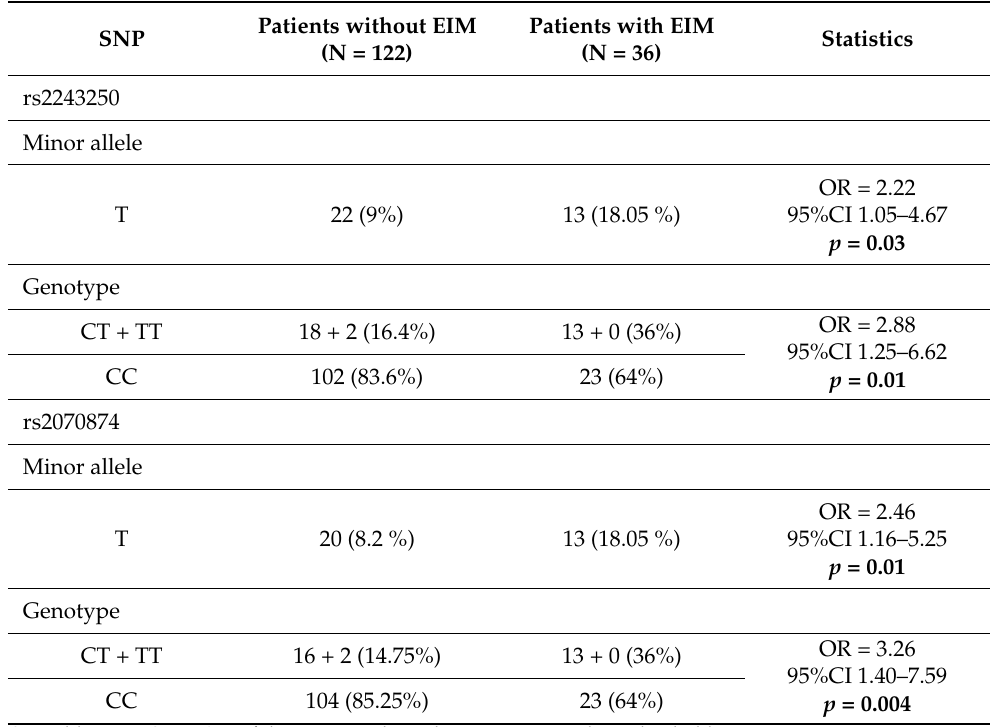
Table 6. Results of the association study of IL-4 single nucleotide polymorphisms and EIM in IBD